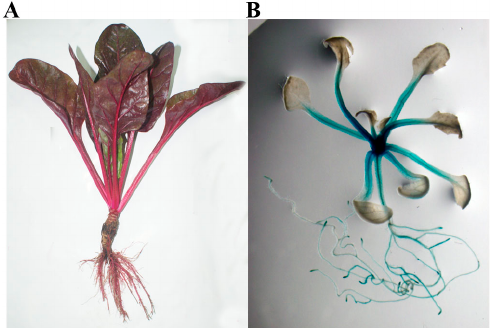
Figure 5. Comparison of betalain distribution and/or accumulation in young red Swiss chard with GUS staining pattern in young plants of BvcPPOP-GUS transgenic Arabidopsis. ( A ) Young red Swiss chard; ( B ) young plant of BvcPPOP-GUS transgenic Arabidopsis.